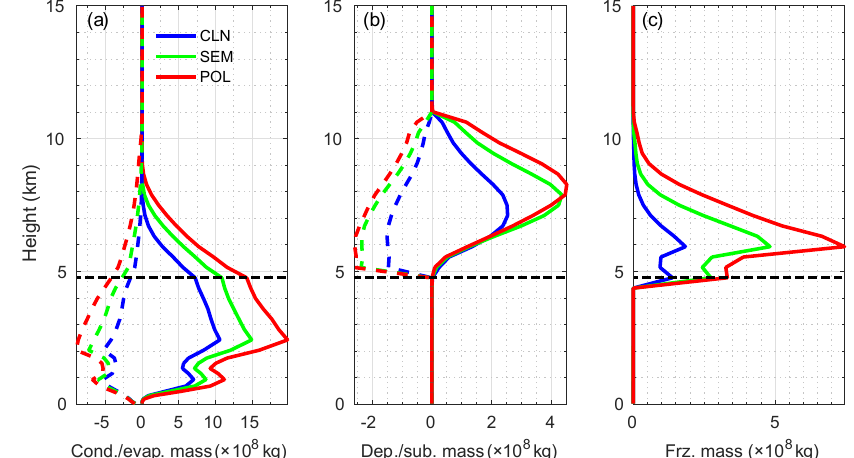
Figure 5. Total changes in cloud mass (kg) over 4 to 12h of the simulation due to (a) condensation/evaporation (solid/dashed curves), (b) deposition/sublimation (solid/dashed curves), and (c) freezing for clean (blue curves), semi-polluted (green curves), and polluted (red curves) experiments. The freezing mass includes both the freezing of liquid drops and riming by ice particles. Note that the x -axis scales are different. The dashed black lines denote the zero temperature level (ZTL; ∼ 4.8km).